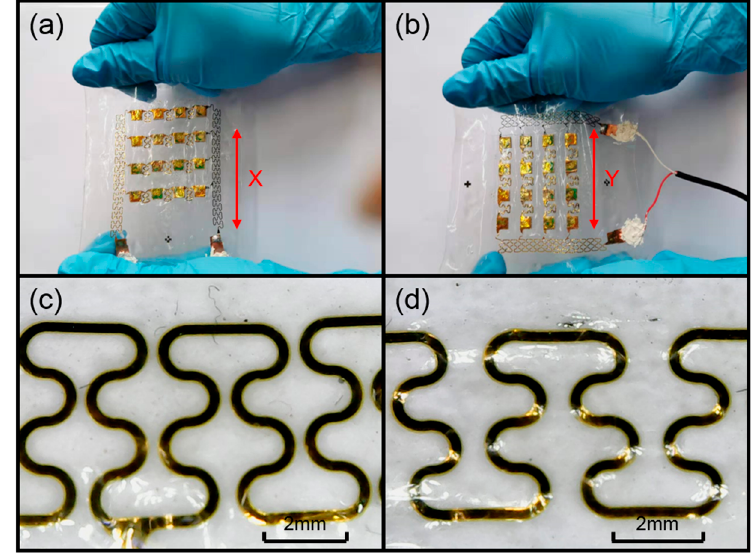
Figure 9. ( a ) Stretching the device along the x axis. ( b ) Stretching the device along the y axis. ( c ) The electrode in its initial state. ( d ) The electrode in its stretched state.